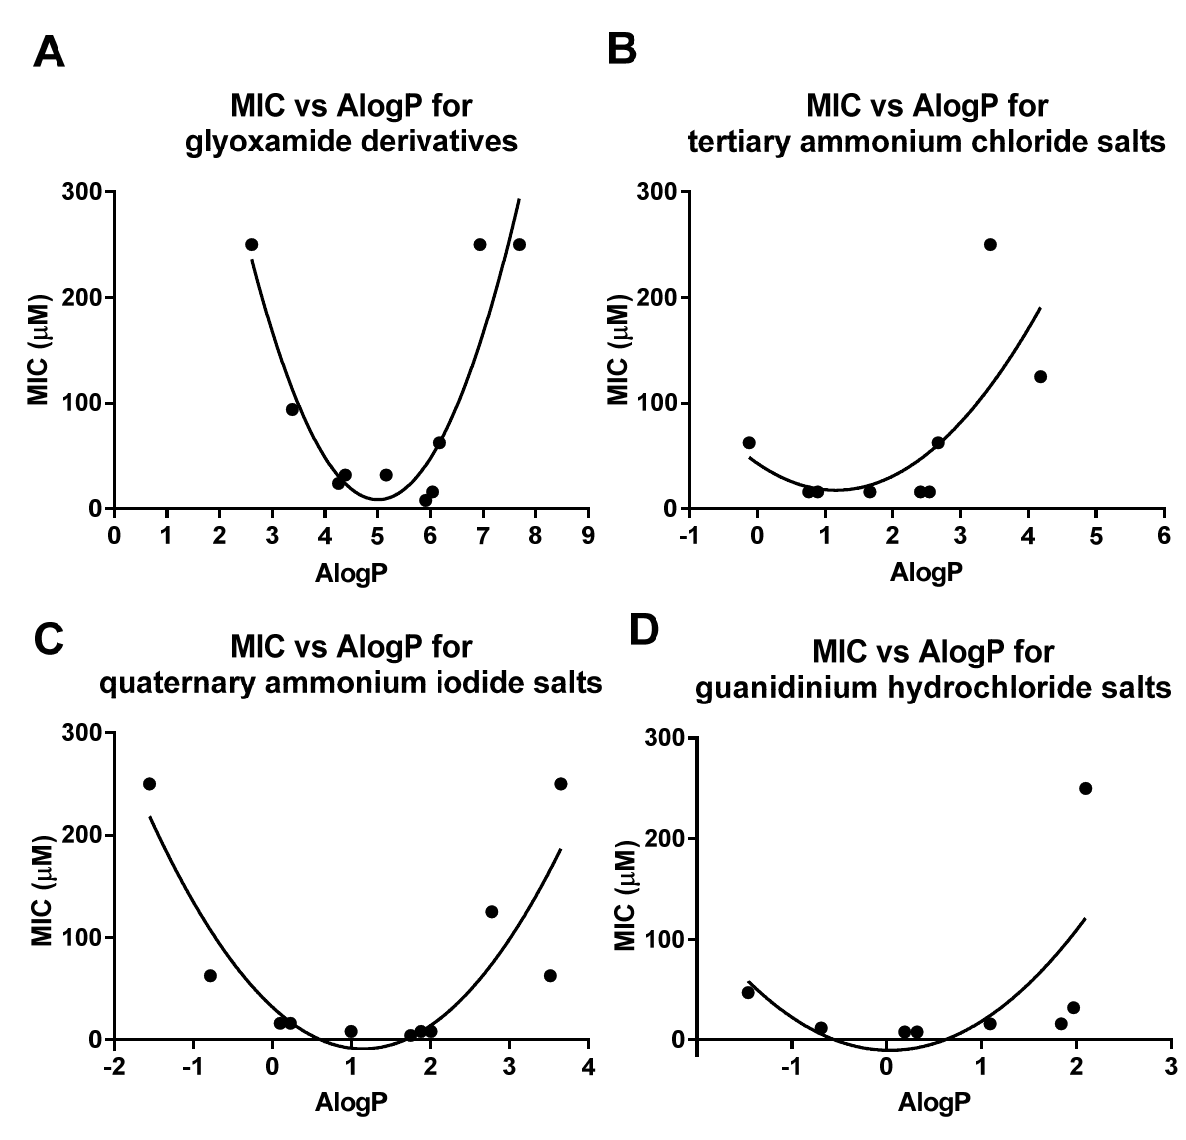
Figure 2. MIC vs. AlogP plot for ( A ) glyoxamide derivatives; ( B ) tertiary ammonium chloride salts; ( C ) quaternary ammonium iodide salts; and ( D ) guanidinium hydrochloride salts.